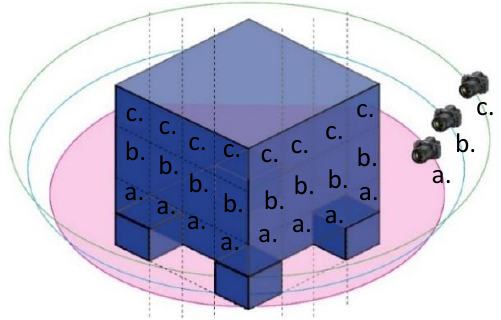
Figure 10. Diagram showing how the exterior photogrammetry was done. a) Below eye-level and closest to the building. b) Eye-level. c) Above eye- level and farthest away from the building. (Drawn by Rajabzadeh,